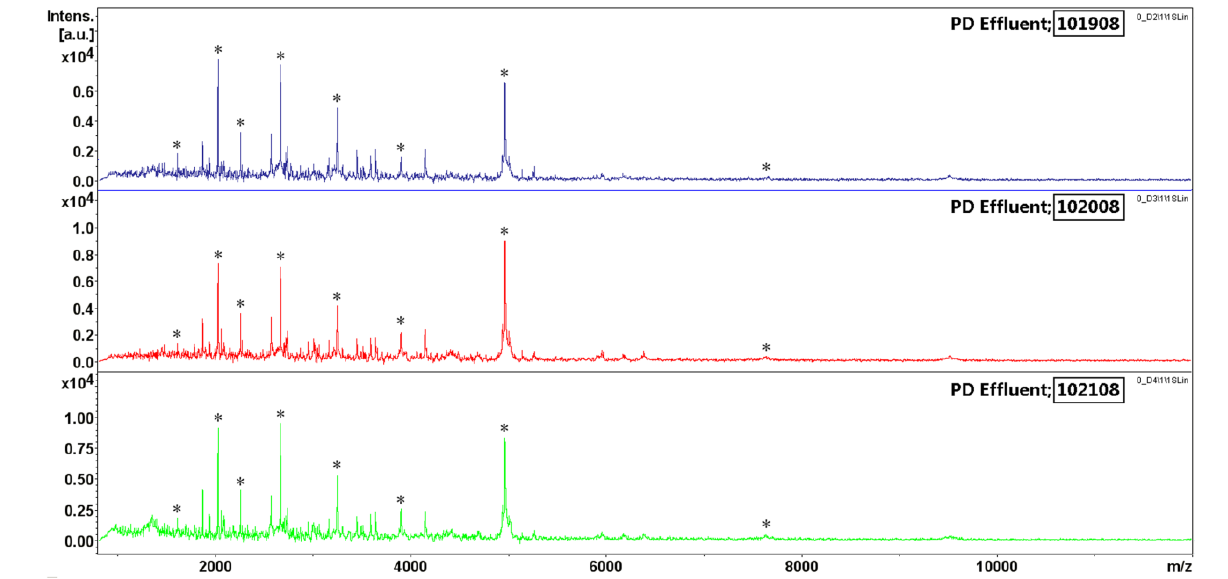
Figure 4. The inter-day reproducibility study for MALDI-TOF MS measurement. The sample was split into three vials and processed on different days (marked 101908;